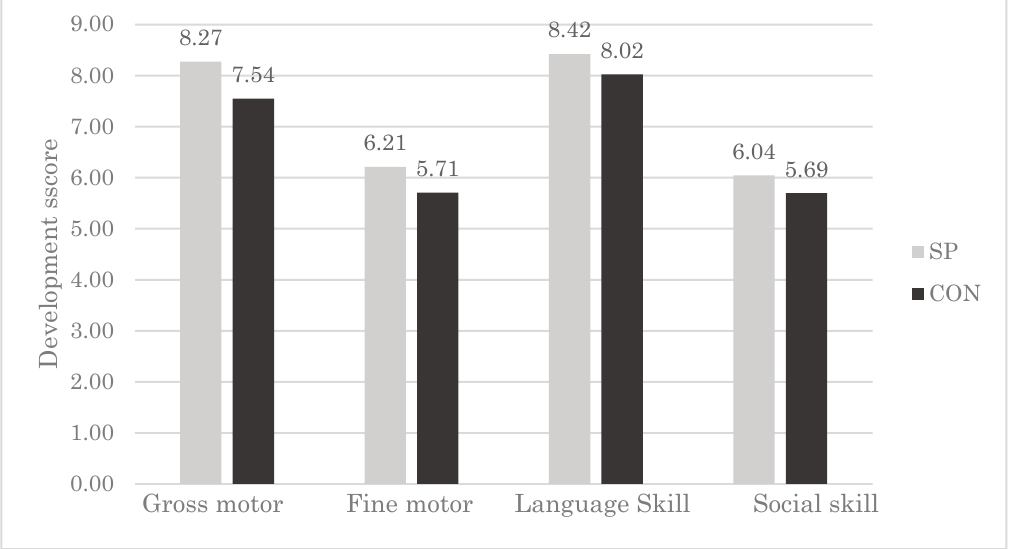
Figure 2. Gross motor development, fine motor development, language skills, and personal–social skills scores of children in each group. SP, maize-soya-based control porridge plus multiple micronutrient spirulina supplementation, which provides vitamins and minerals; CON, maize-soya-based control porridge supplementation. Gross motor scale, 0–10 fine motor; 0–8 language skills, 0–11; and personal–social skills, 0–8. Table 2. The effects of spirulina intervention on child development